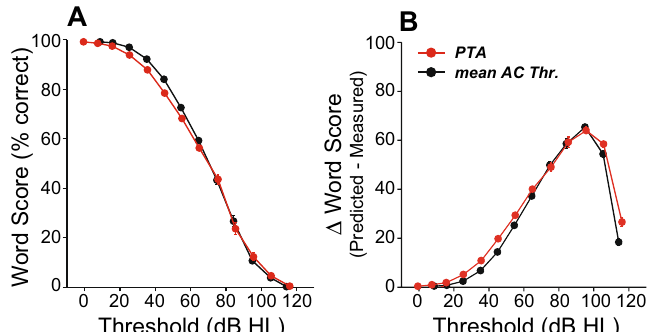
Figure 4. Intelligibility worsens with degree of sensorineural hearing loss. Intelligibility deficits assessed by measuring word recognition scores at PB max ( A ) or by calculating the difference between measured word score and score predicted by the speech intelligibility curve ( B ) show a progression of intelligibility deficits with degree of hearing loss as measured using the pure-tone average (PTA) or mean Air-Conduction thresholds across test frequencies (mean AC Thr.). Error bars are standard error of mean.